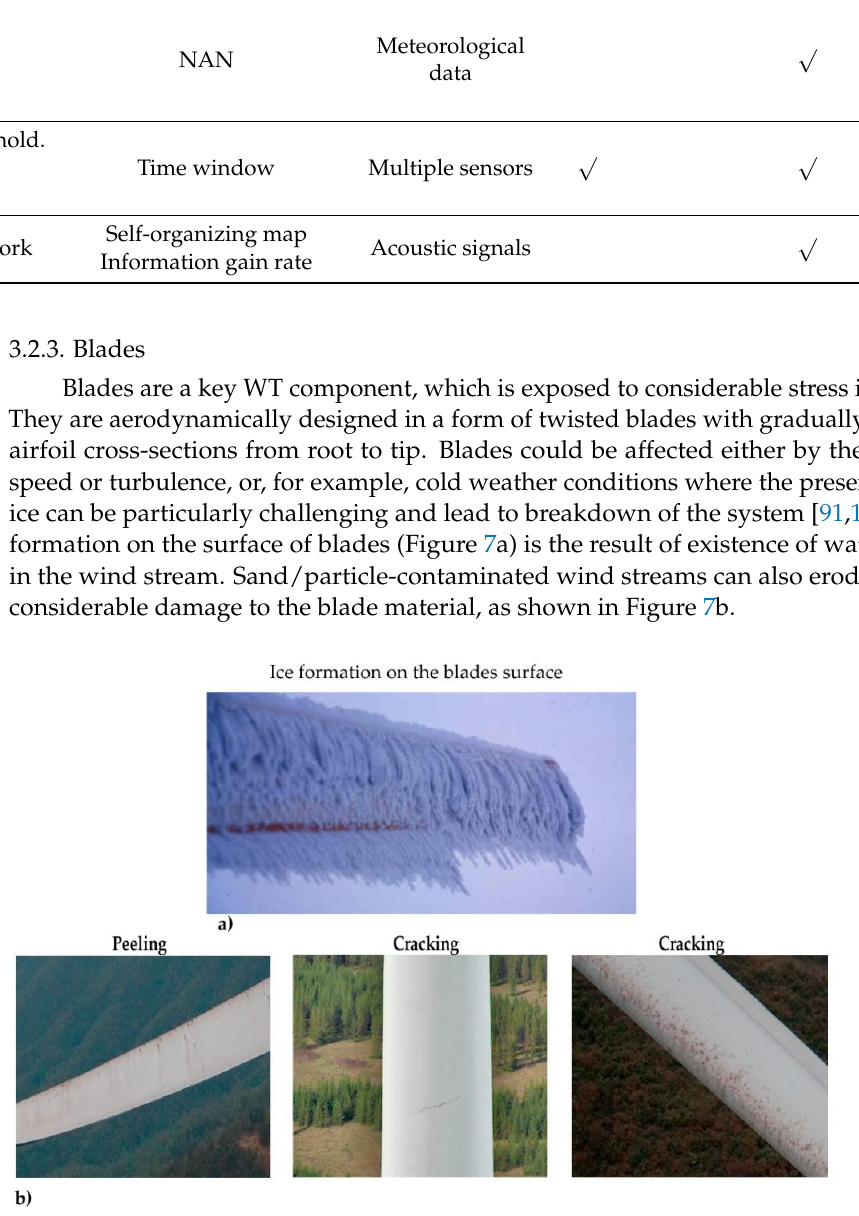
Figure 7. Icing phenomenon and blade failure types. ( a ) Icing phenomenon. Reproduced from [115], Elsevier. ( b ) Different possible failures types. Reproduced from [92], Elsevier.